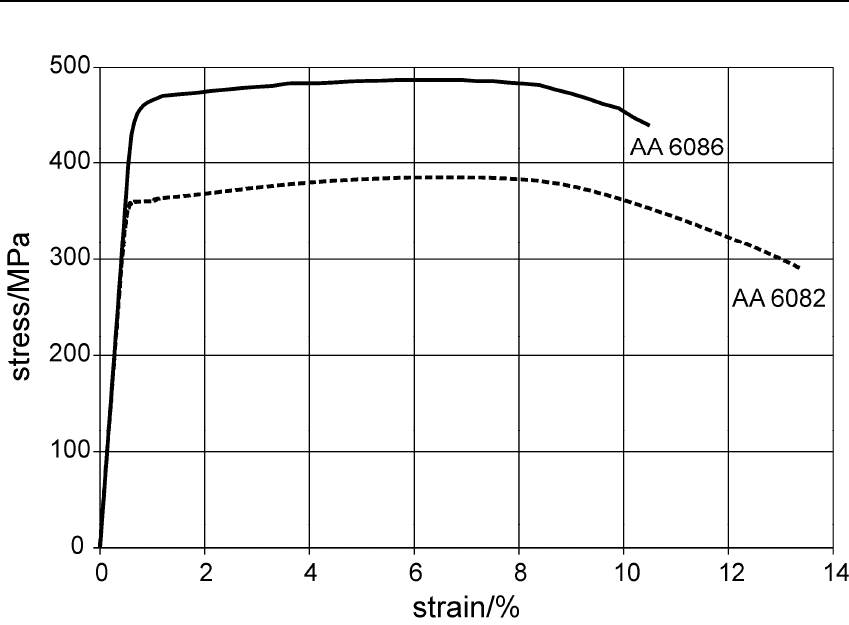
Figure 13. A Q ′ -precipitate. ( a ) The high resolution TEM micrograph of the Q ′ - precipitate in α -Al, ( b ) EDS-spectrum, ( c ) FFT of the HR-TEM micrograph, ( d ) model of FFT (Open circles: α -Al, black dots: Q ′ -precipitate.